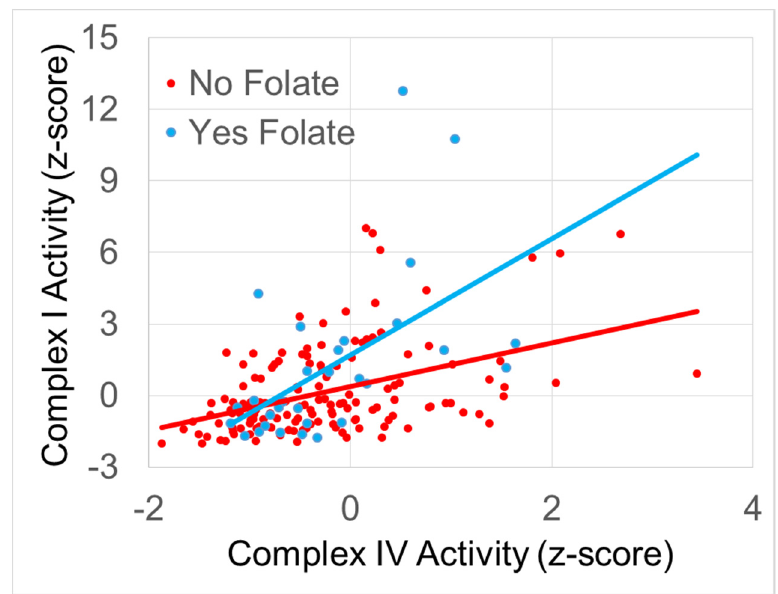
Figure 1. The relationship between Normalized Complex I and IV activity. Folate supplementation is associated with a significantly greater slope in the relationship between complex activities.